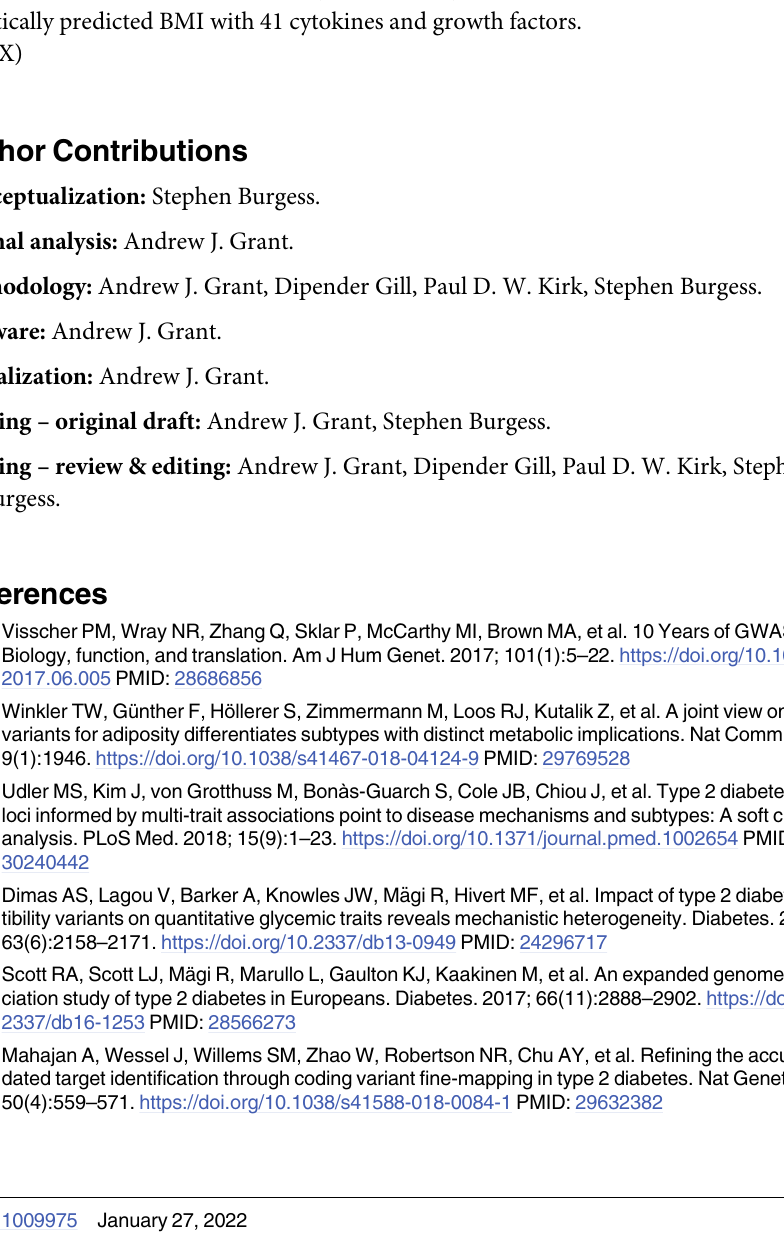
S1 Table. Allocated cluster and probability of membership to each cluster for each BMI associated genetic variant. S2 Table. List of canonical pathways and gene ontology processes associated with the mapped genes for each cluster of BMI associated genetic variants. S3 Table. Results from Mendelian randomization sensitivity analyses of the effect of BMI on cytokines and growth factors. Estimates and 95% confidence intervals from MR-Median, the Contamination Mixture method (MR-ConMix) and MR-PRESSO for the association of genetically predicted BMI with 41 cytokines and growth